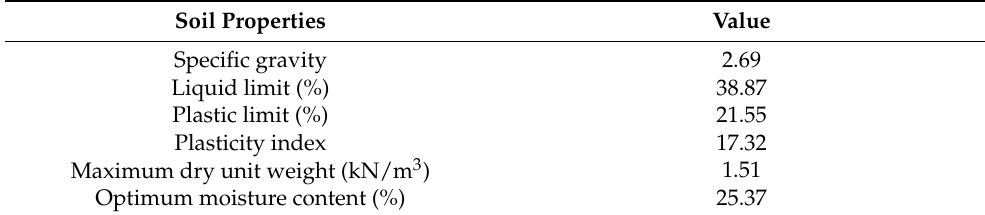
Table 1. Physical and mechanical properties of soil sample.